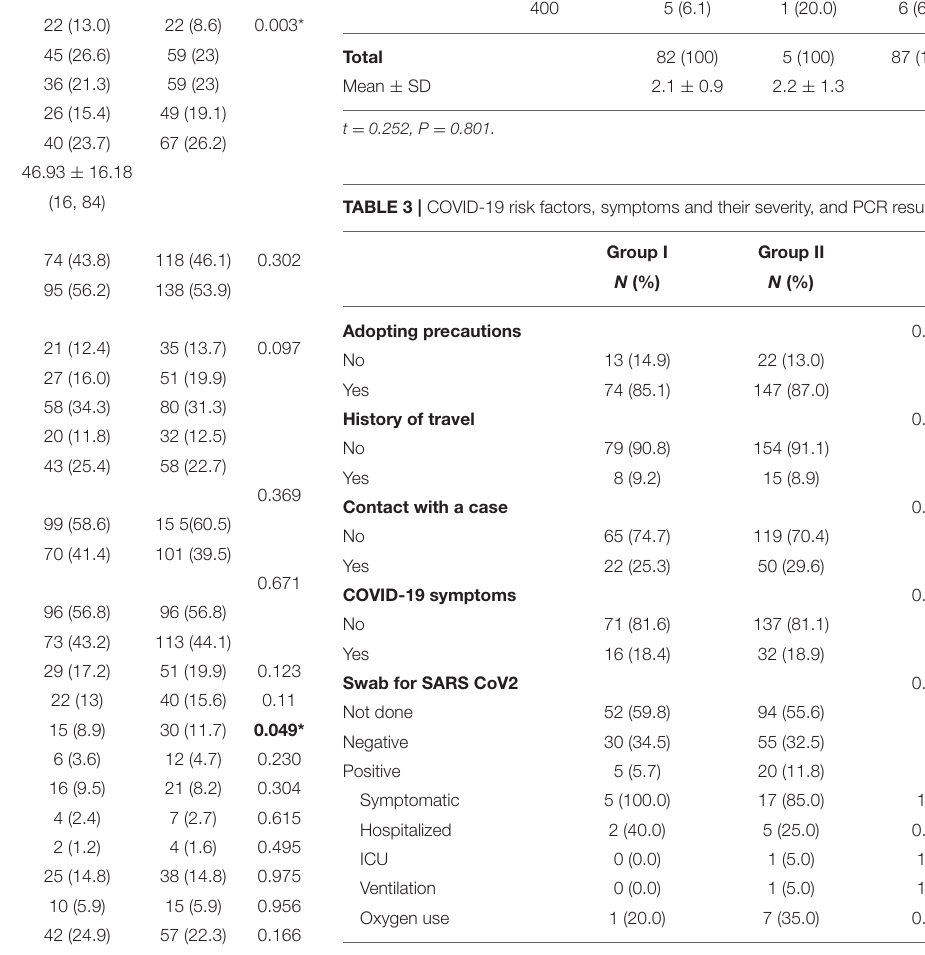
Regarding the COVID-19 symptoms, almost the same percentage of patients in both groups have symptoms suggestive of COVID- 19 infection (18.9 vs. 18.4%). 40.2% of the total number of patients in group I underwent PCR testing for